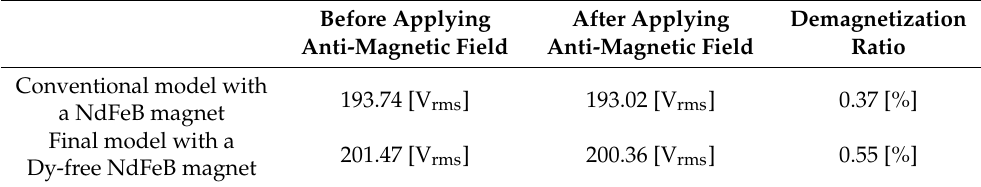
Table 3. Comparison of the back electromotive force and demagnetization ratio and FEM results of the conventional model that used a magnet containing Dy and the final proposed model that USED a Dy-free